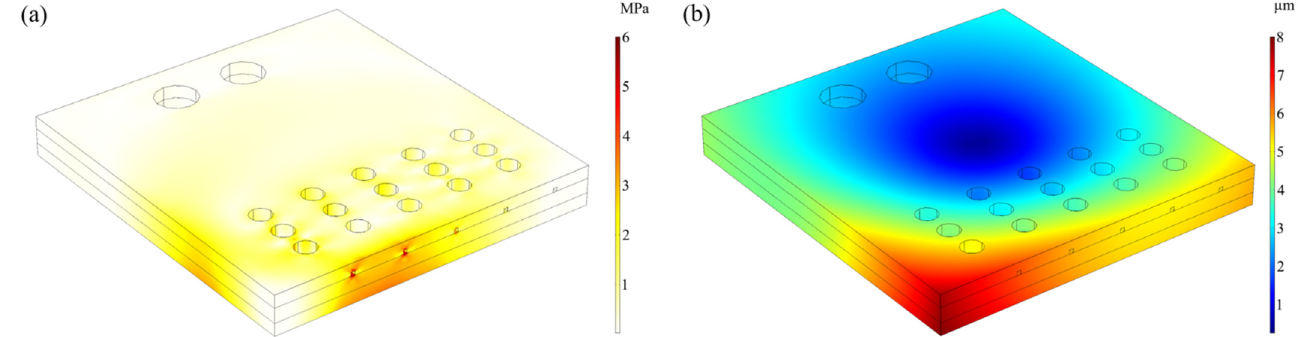
Figure 5. Thermal stress on microfluidic chips. ( a ) Von Mises effective stress caused by heat. The values of von Mises effective stress are shown in the legend on the right. ( b ) Displacement caused by heat. The values of displacement are shown in the legend on the right.